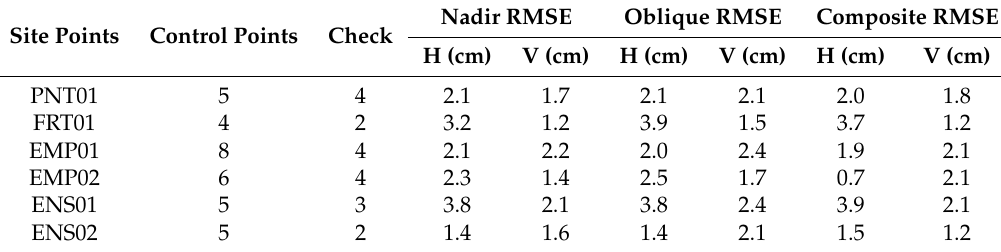
Table 3. The number of control and check points along with the horizontal (H) and vertical (V) root mean square error (RMSE) of the check points in each photoset. Although up to 15 ground control points were distributed in the area surrounding each plot these were not always present in four or more images of each photoset. As such a common set of control and check points were used at each site for each photo set.